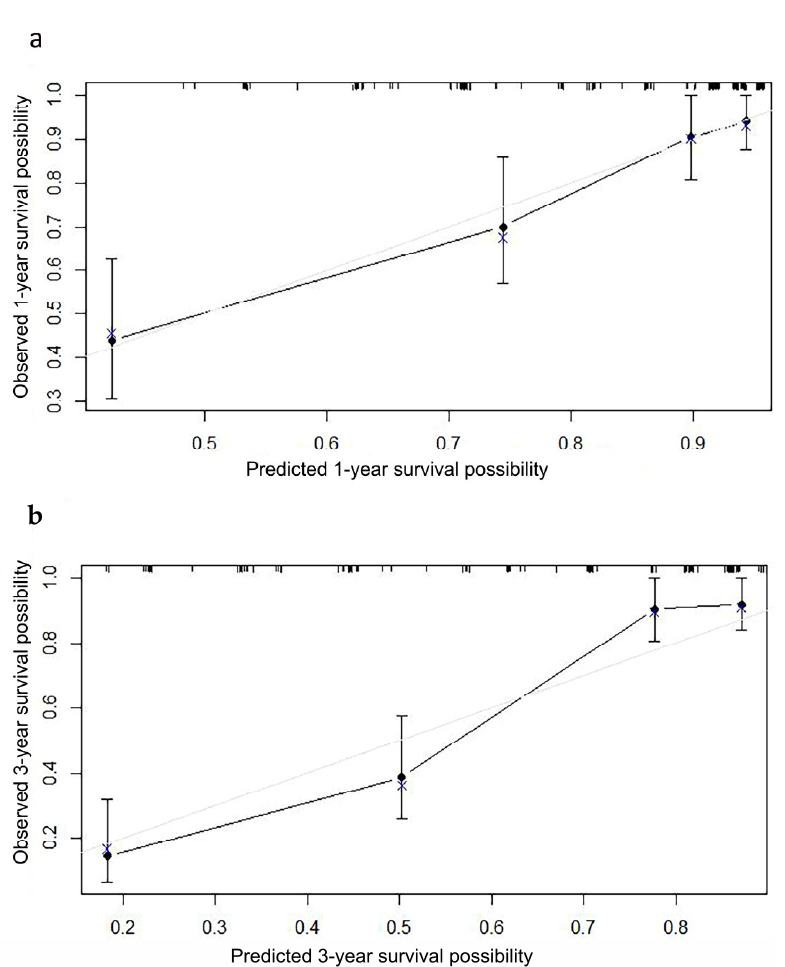
Figure 4. The 1000 bootstrap resampling internal verification correction for the nomogram of ( a ) 1- year overall survival, ( b ) 3-year overall survival in primary bile duct and ampullary neuroendocrine neoplasms patients.